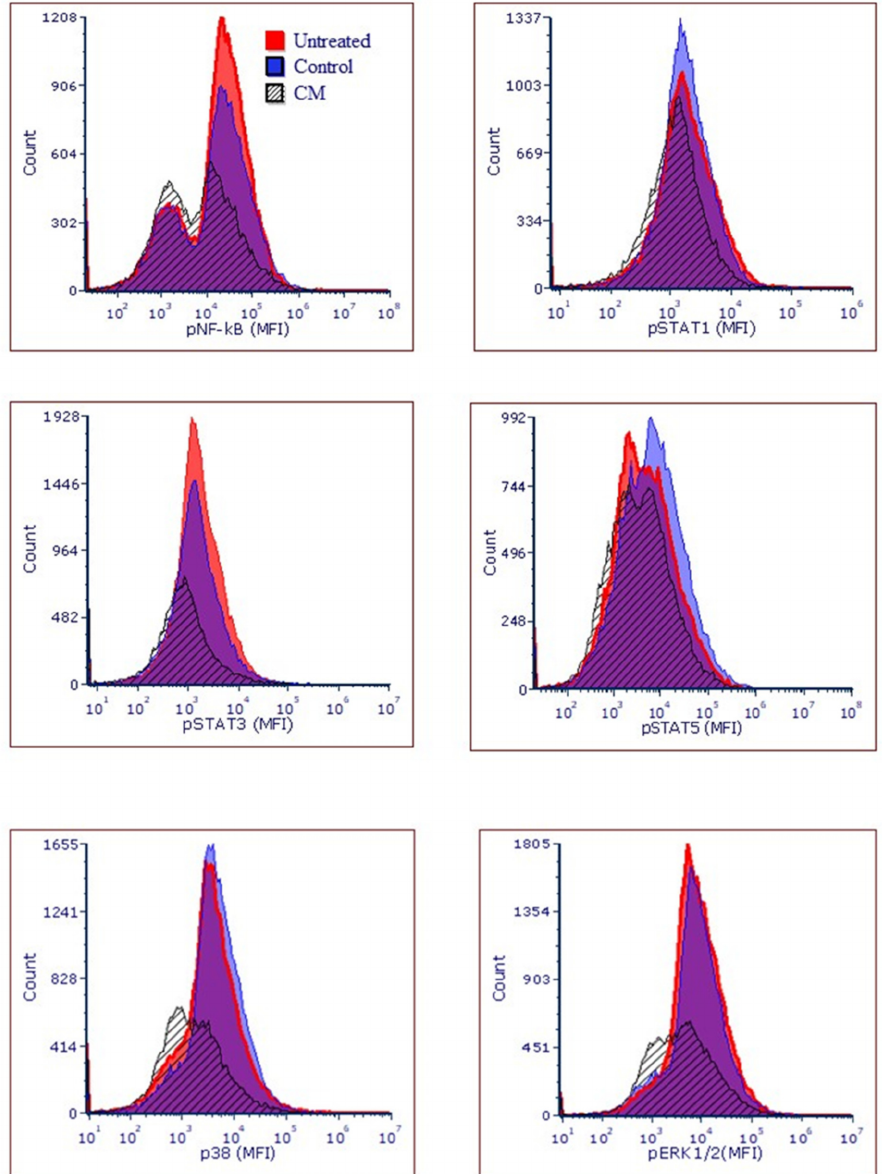
Figure 8. The expression of pNF- κ B (76.55 ± 5.8 vs. 49.65 ± 2.9% of positive cells), pSTAT1 (18.35 ± 8.9 vs. 7.63 ± 3% of positive cells), pSTAT3 (17.78 ± 6.7 vs. 2.75 ± 0.3% of positive cells), pSTAT5 (65.16 ± 11.4 vs. 51.43 ± 5.3% of positive cells), p38 (53.84 ± 1.9 vs. 33.7 ± 12.6% of positive cells) and pERK1/2 (60.29 ± 13.07 vs. 50.9 ± 4.9% of positive cells) in both and CM-treated and untreated Ca9-22